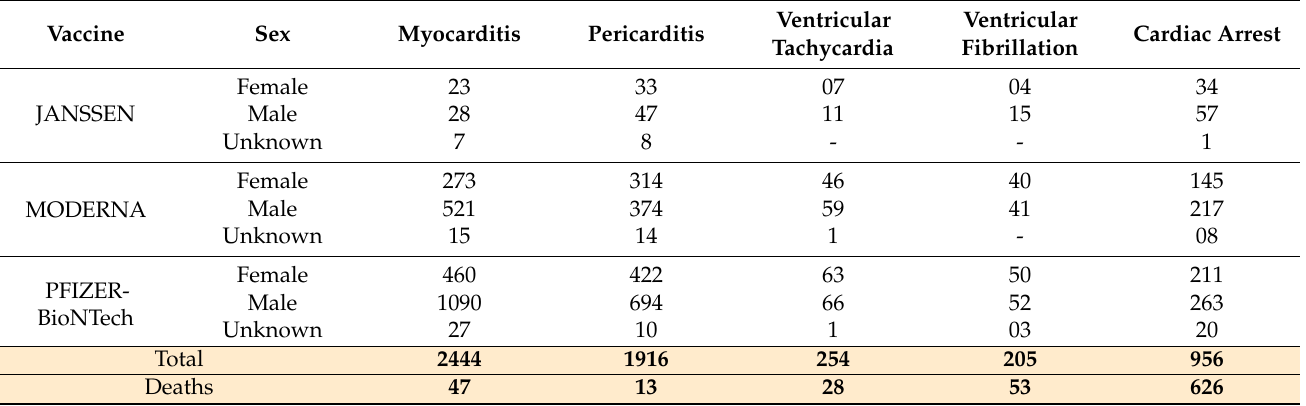
Table 1. Cardiac adverse events post-COVID-19 vaccination.